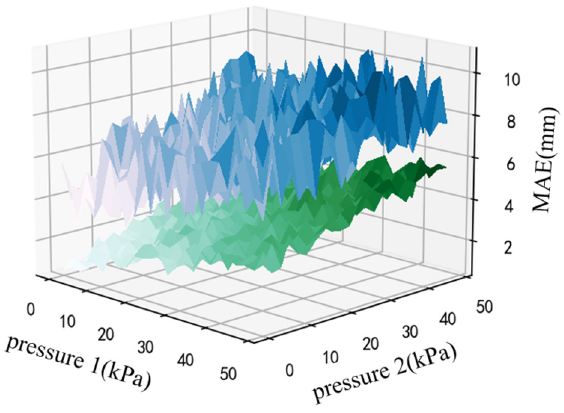
Figure 9. Influence of the air pressure on the MAE. The blue and green colors represent the error distribution of the model before and after optimization.